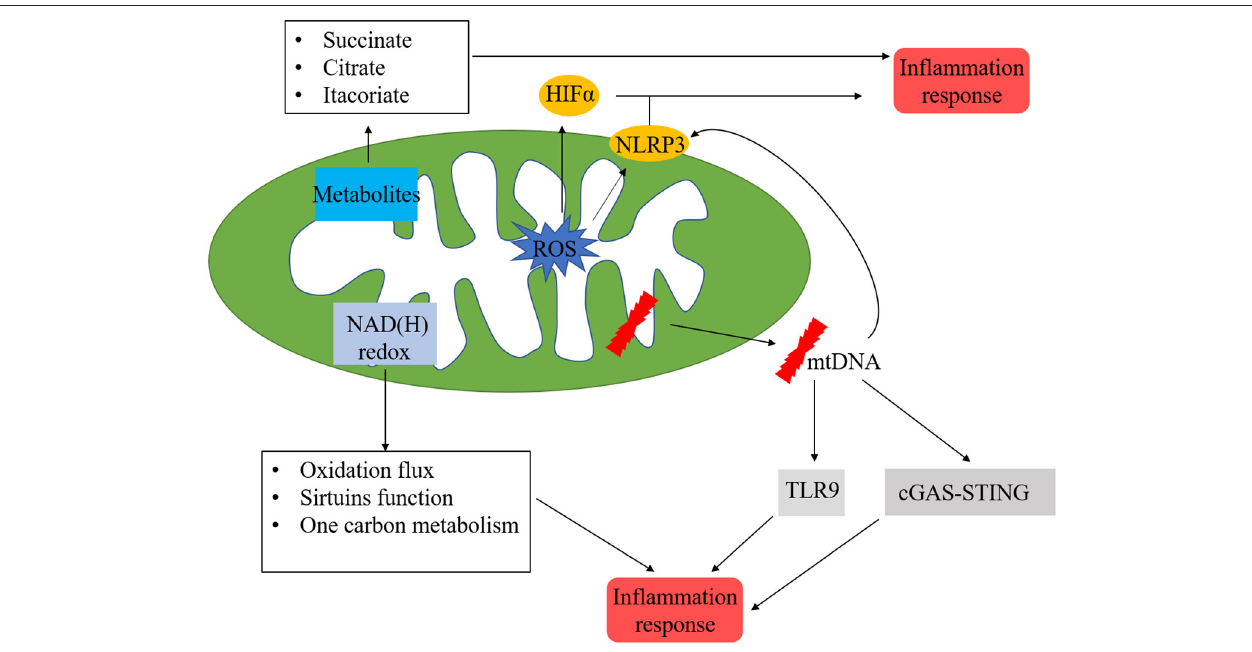
FIGURE 5 | Mitochondria-related inflammation in ischemic heart disease. Many factors in mitochondria could initiate mitochondria-related inflammation, ROS from mitochondrial respiratory chain could directly activate HIF α and NLRP3, which are vital regulators in inflammation process. In addition, metabolites from mitochondria, such as succinate, citrate, and itacoriate also cause inflammation. mtROS could lead to mtDNA damage, which trigger the inflammation response via NLRP3, cGAS/STING, and TLR9 pathways. NAD(H) redox is another initiator of inflammation response via the regulation of oxidation flux, sirtuins function, and one carbon